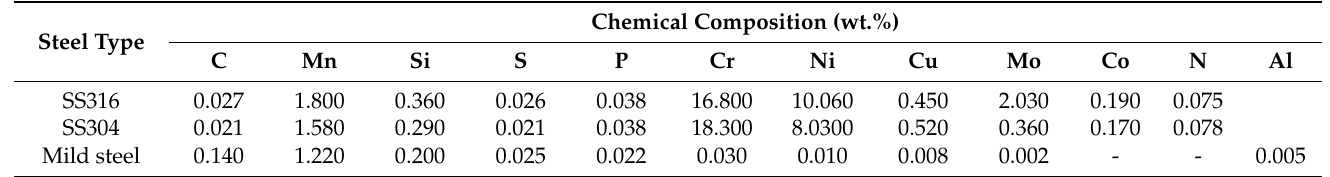
Table 1. Chemical composition of steels used in the present study.